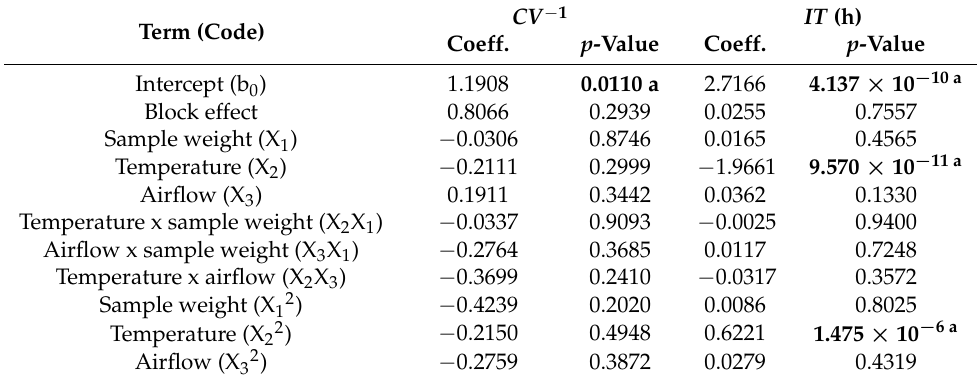
Table 2. Regression coefficients and p -value a for each non-linear response variable